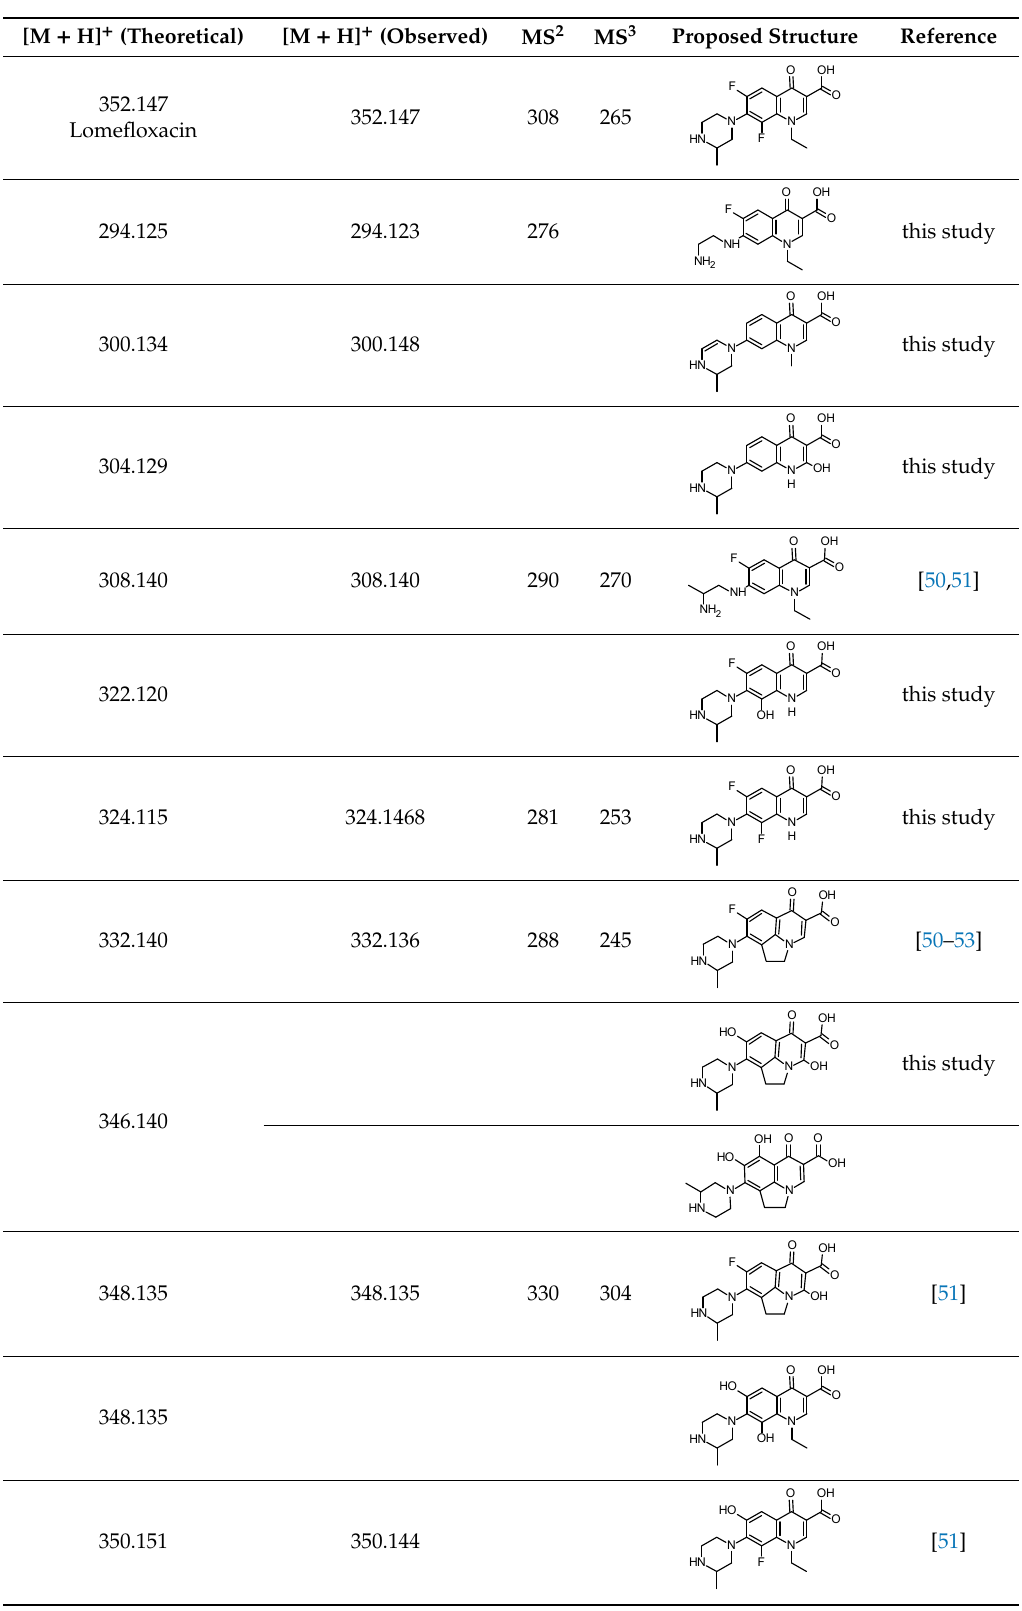
Table 4. Photoinduced transformation products and their purposed structure. Identification using MS and MS/MS experiments.